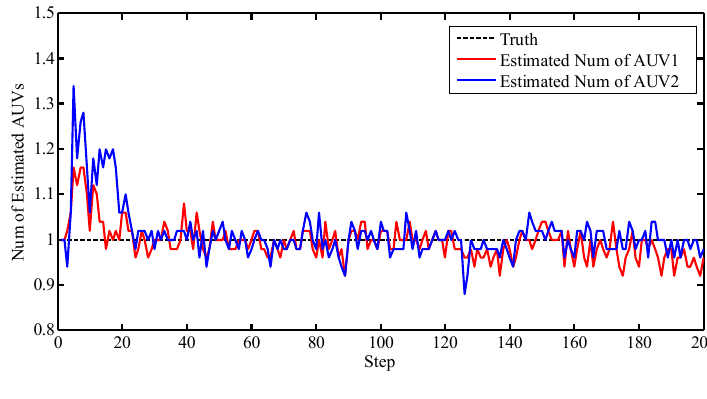
Figure 13. Number of estimations.